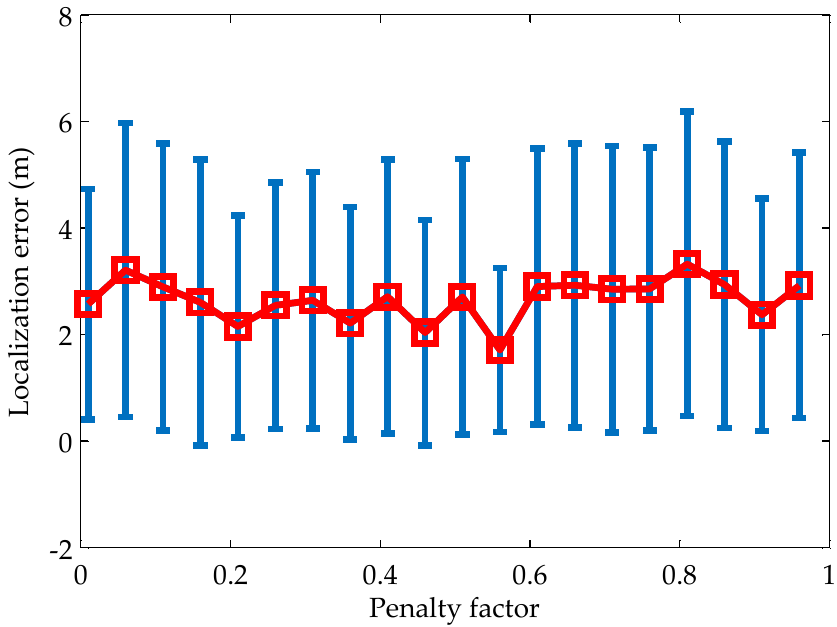
Figure 3. Impacts of the penalty factor on localization